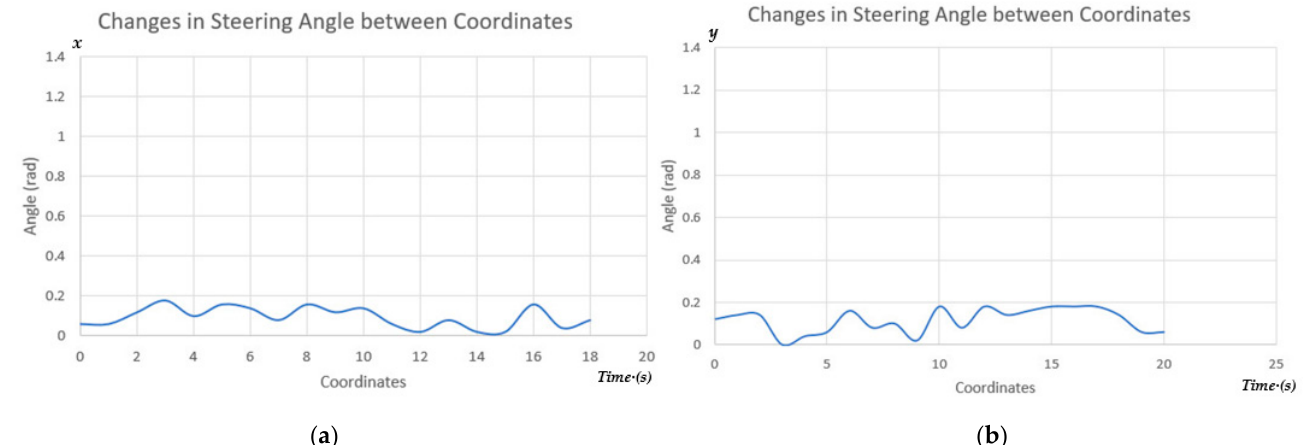
Figure 22. Changes in steering angle while mobile robot is tracking optimal trajectory: ( a ) steering angle between coordinates in x axis, ( b ) steering angle between coordinates in y axis.